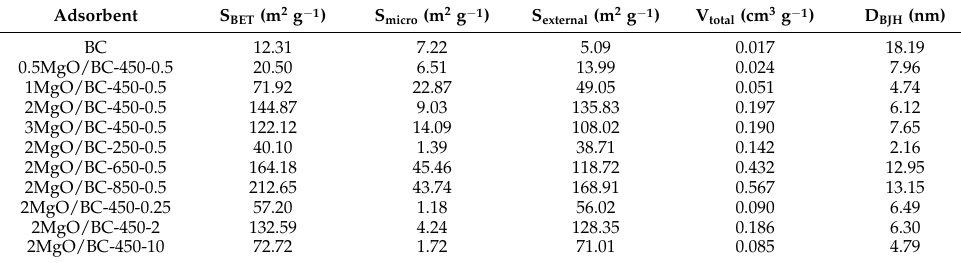
Table 1. Physical properties of biochar samples.